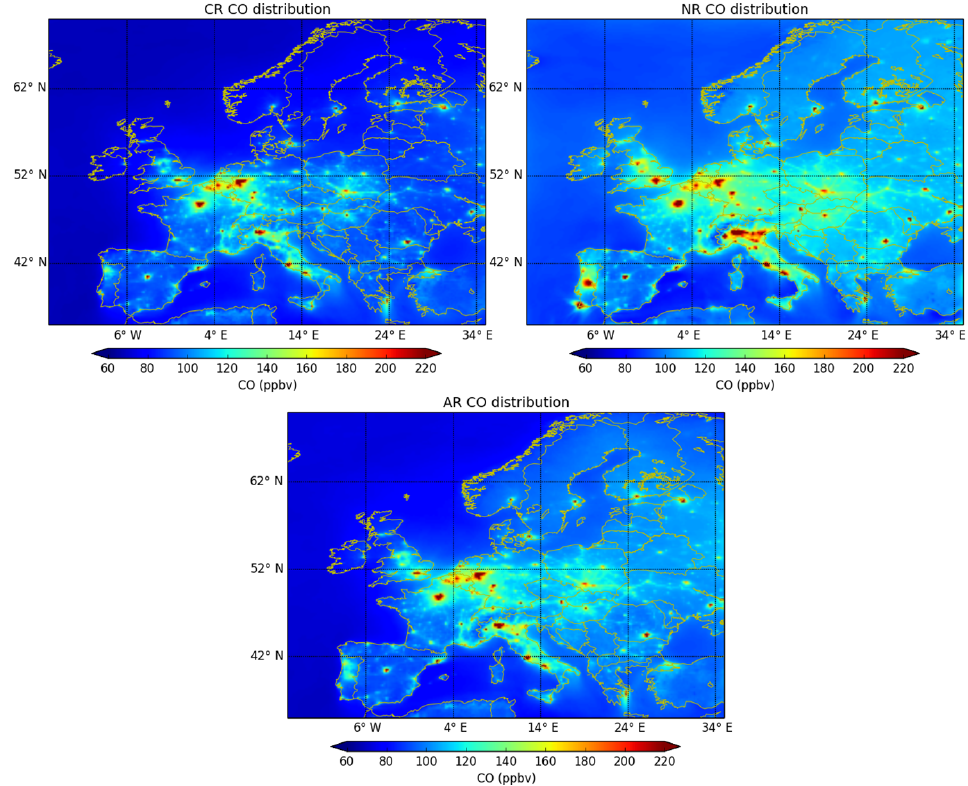
Figure 8. Distribution of CO surface concentrations, units of ppbv, averaged for the period 1 June–31 August 2003. Top left panel: the control run (CR) from MOCAGE; right top panel: the nature run (NR) from LOTOS-EUROS; bottom panel: the assimilation run (AR) from MOCAGE obtained after assimilating the S-5P CO total column simulated data sampled from the NR. In all panels, the labels show longitude in degrees ( x axis) and latitude in degrees ( y axis). Red/blue colors indicate relatively high/low values of the CO surface concentrations.